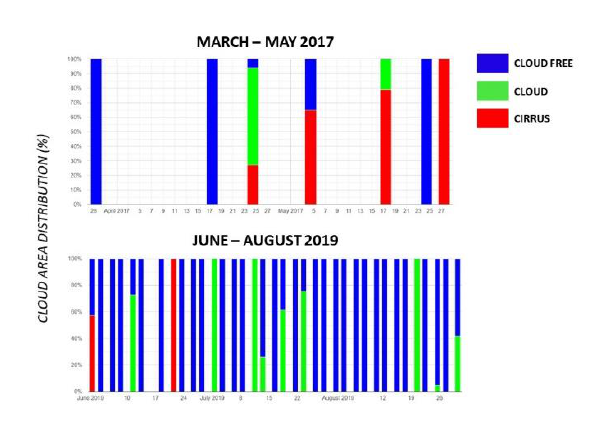
Figure 2. Cloudiness of available Sentinel 2 data over two different time scales in Sinop Nuclear Power Plant Construction Area. Figure 1. The map of (a) Turkey, and satellite images of (b) construction area of Sinop nuclear power plant, (c) construction area in 2016, and (d) construction area in 2019 (©Google Earth).